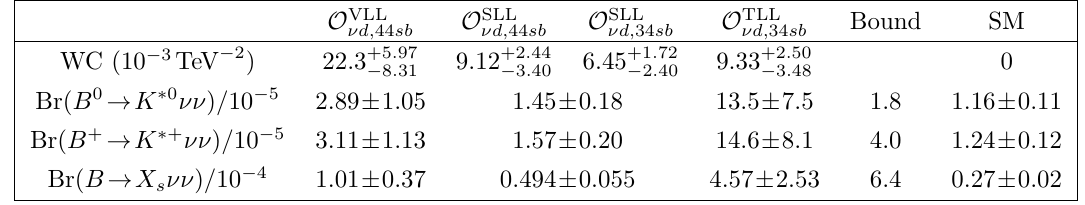
Table 3 . Implication of the non-zero simple weighted average of Br ( B + → K + νν ) for the con- tributing WCs and the other decay channels. The indicated upper and lower ranges reflect the uncertainty at 1 σ . Note that our new-physics predictions for the inclusive mode do not take into account QCD and HQET corrections, as indicated in section 3, and are thus expected to be over- estimated by O (10 − 20%) . All bounds and SM predictions are the same as in table